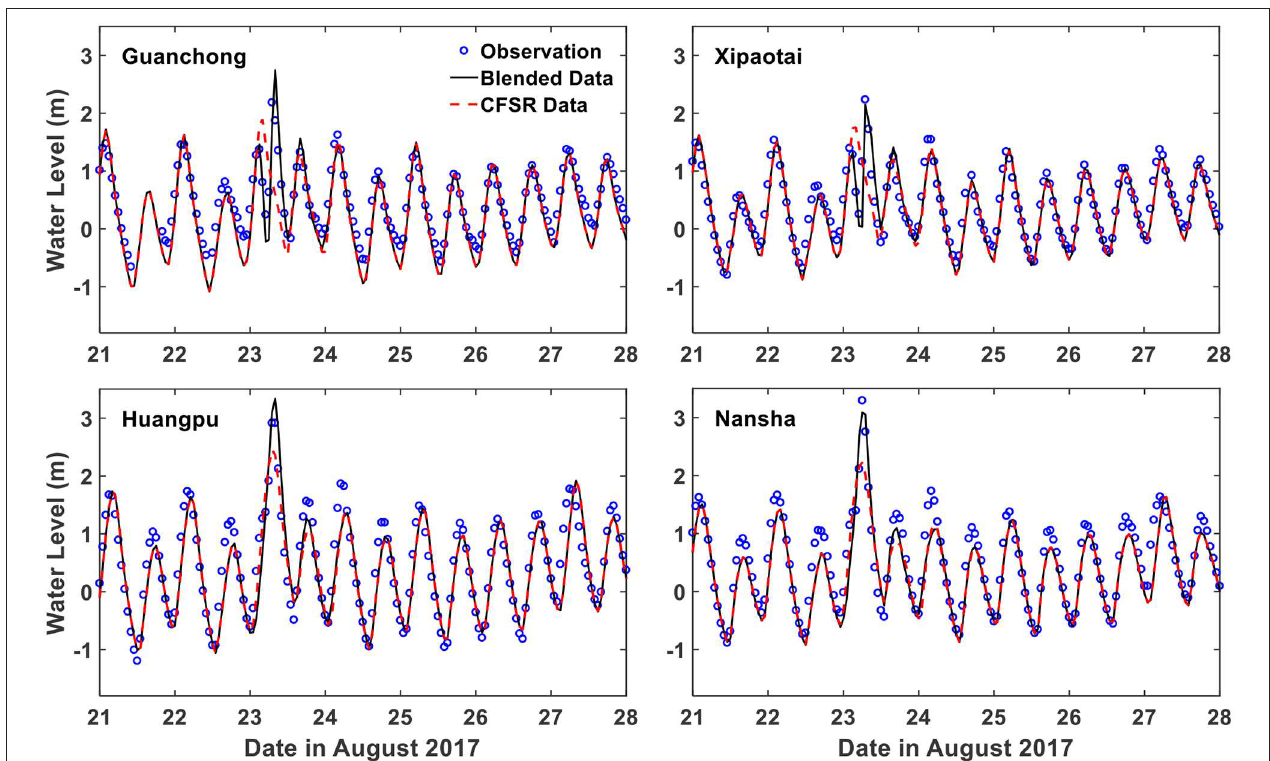
FIGURE 5 | Comparisons of model-predicted (lines) with observed (circles) time series of water level over August 21–28, 2017.